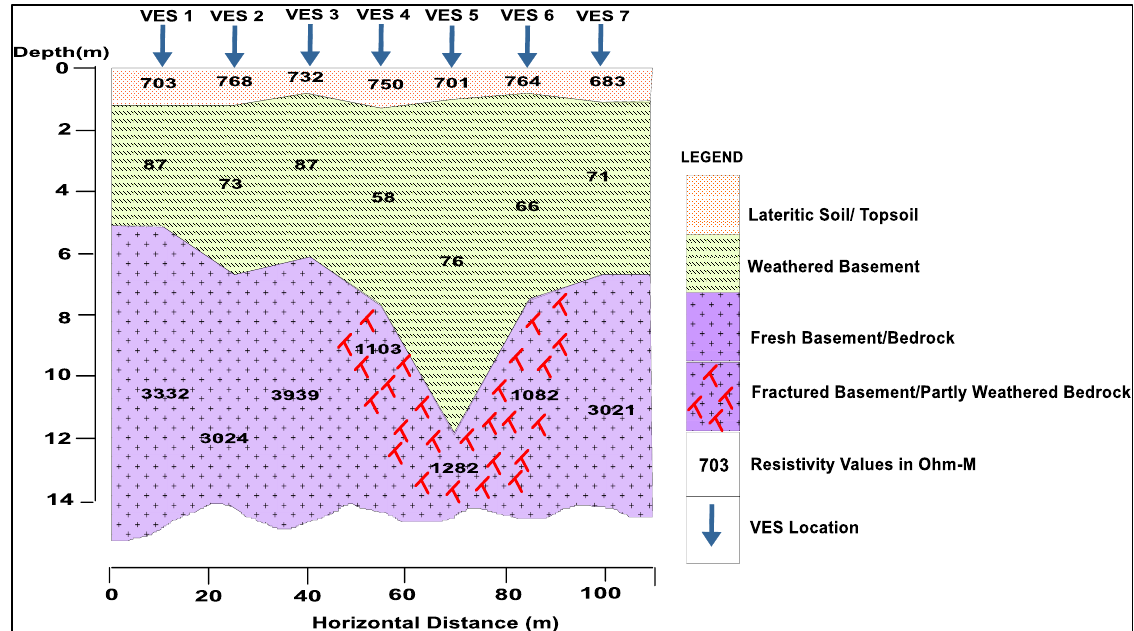
Figure 5: 2-D Geoelectric Section along the